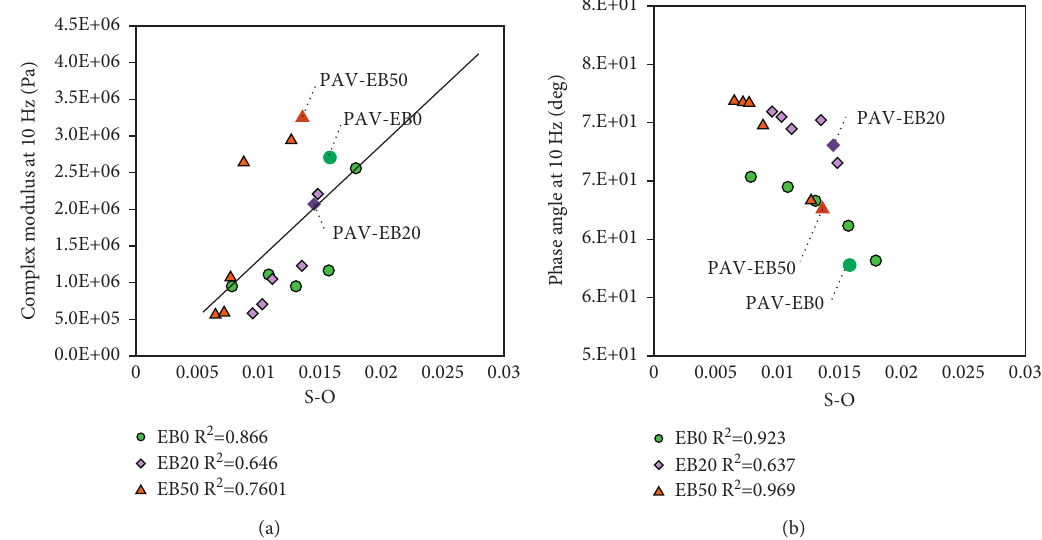
Figure 21: Relationship between sulfoxide compounds and complex modulus (a) and phase angle (b) during oxidative controlled curing